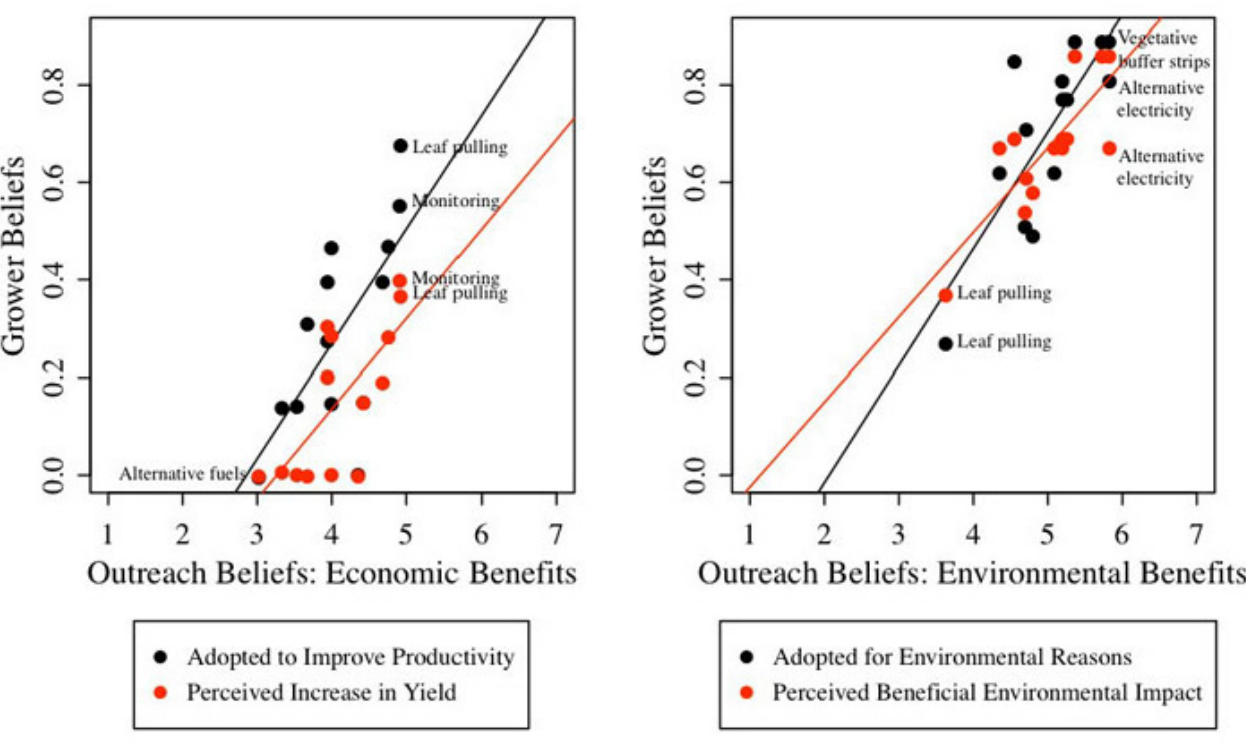
Fig. 3. Correlation between outreach professional and grower